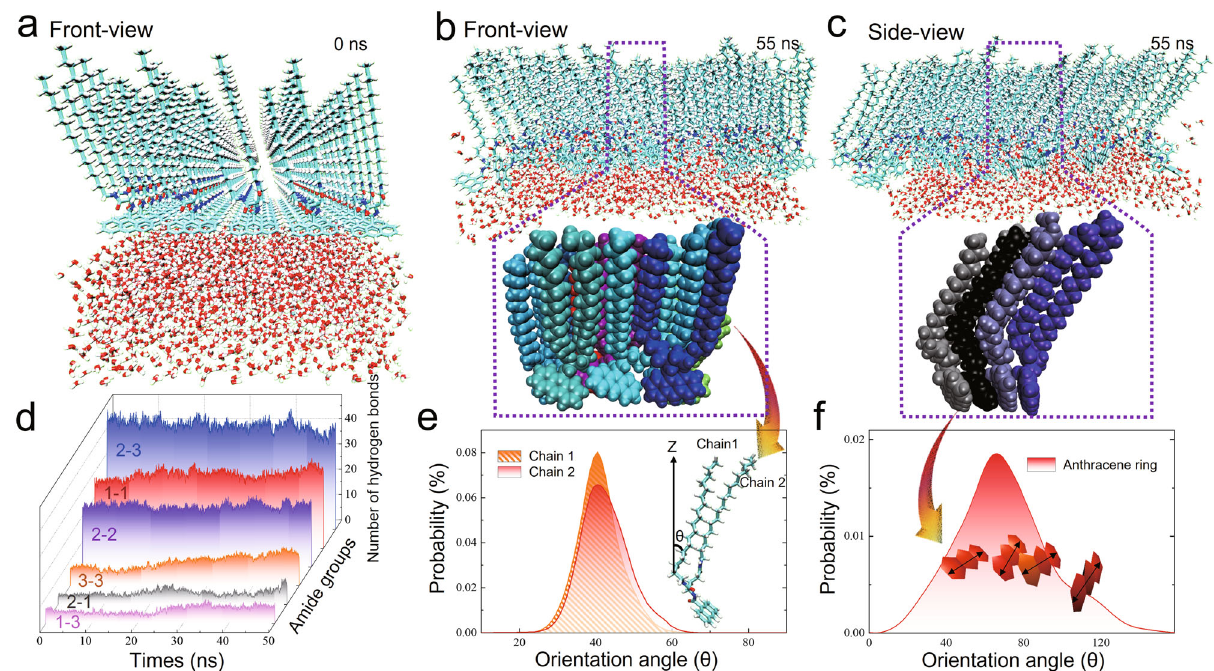
Fig. 3 | MD simulation results of chiral supramolecular structures formed by the self-assembly of L -GAn molecules at the air/water interface. a Front-view of the initial system snapshot of the L -GAn simulation system (for clarity, only 50 L - GAnmoleculesandsomewatermoleculesareshown). b Front-view,and c side-view system snapshots of the last frame after a 50ns MD simulation of the L -GAn simulation system at the air/water interface (100 L -GAn molecules and some water molecules). To clearly observe the assembly arrangement of the L -GAn molecules, the last frame of several molecules located in the central area of the box is also shown (snapshots of all L -GAn and water molecules are shown in Supplementary